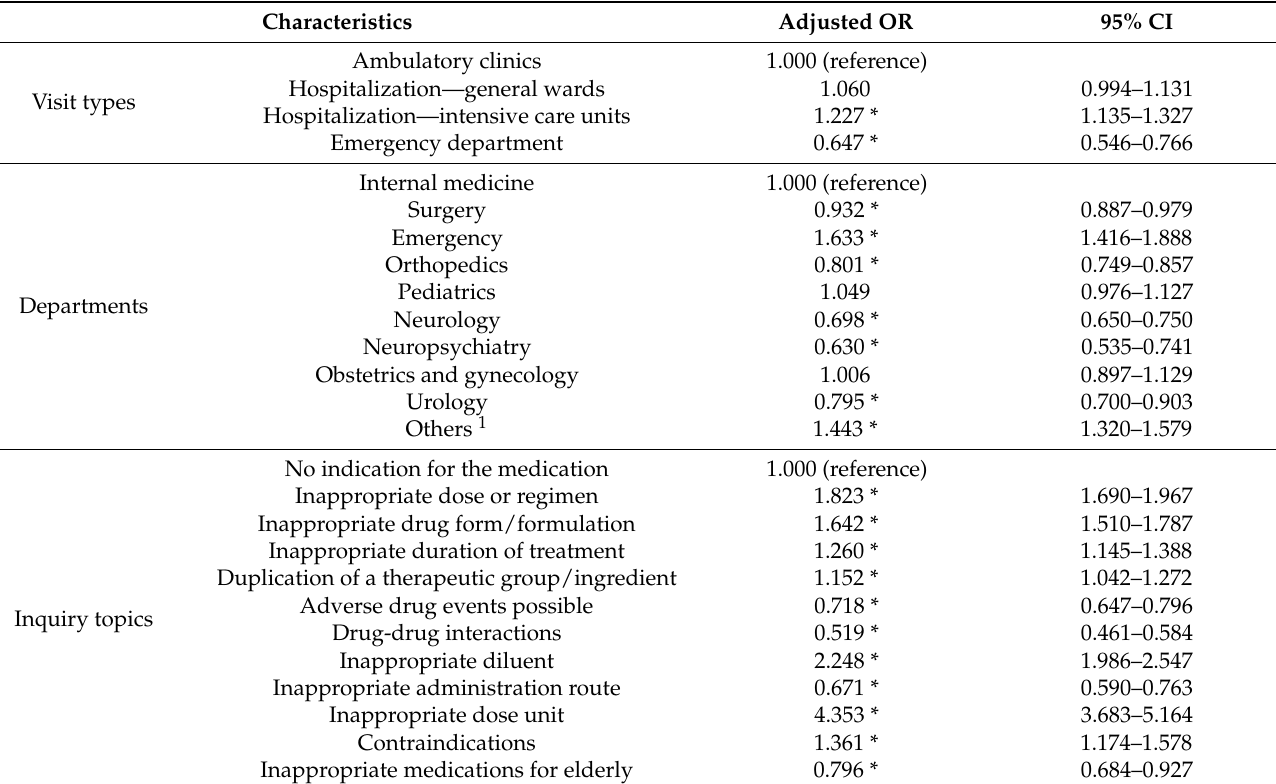
Table 4. Associated factors for discontinuation of prescription orders on